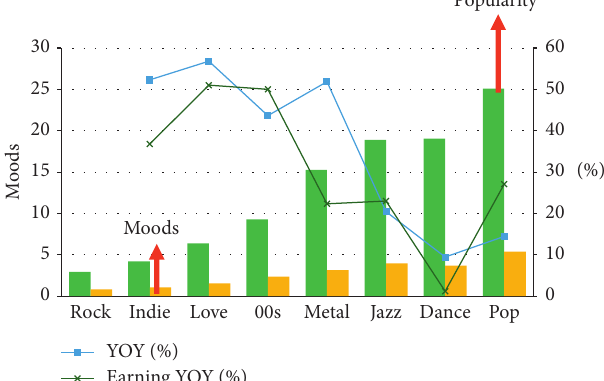
F ( x )). Figure 5: Moods and corresponding